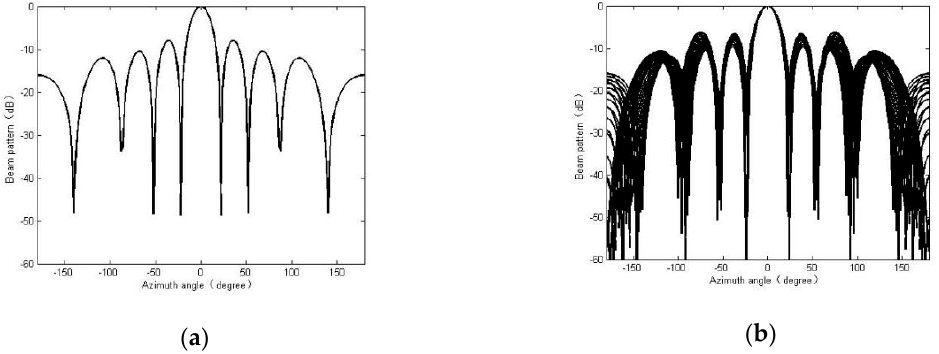
Figure 5. Experimental comparison of focusing frequency at 3000 Hz. ( a ) Narrowband beam pattern at 3000 Hz; ( b ) broadband beam pattern focused on the focusing frequency of 3000 Hz. Table 1. Comparison of beamforming parameters for narrowband signals.